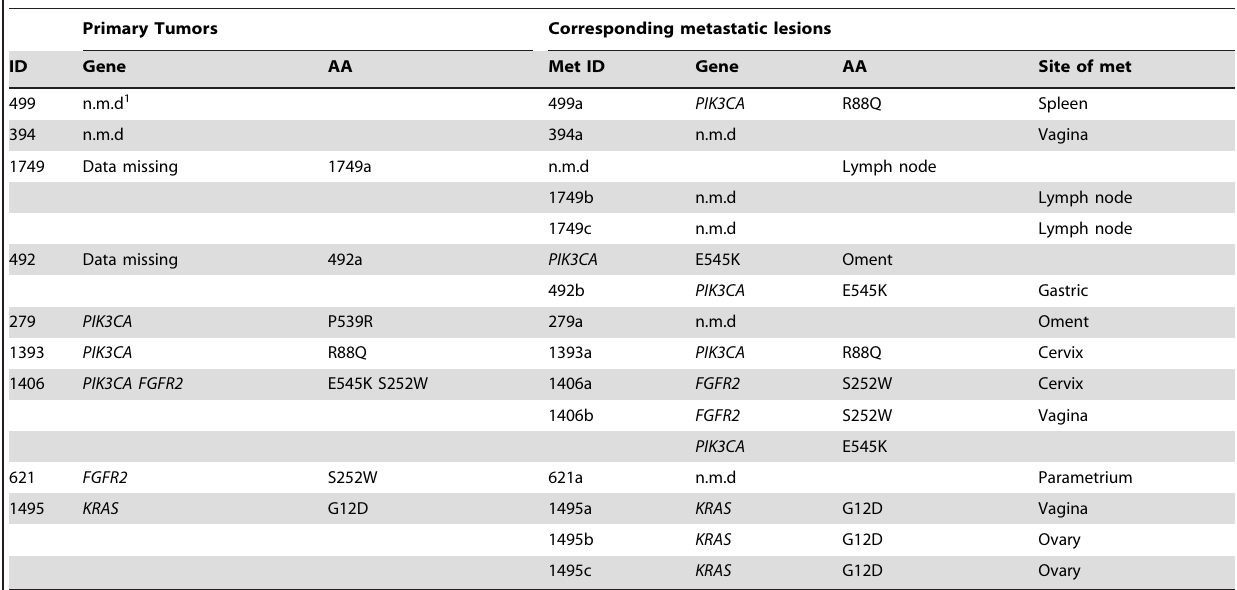
Table 4. Mutational status in primary endometrial cancers and corresponding metastatic lesions.